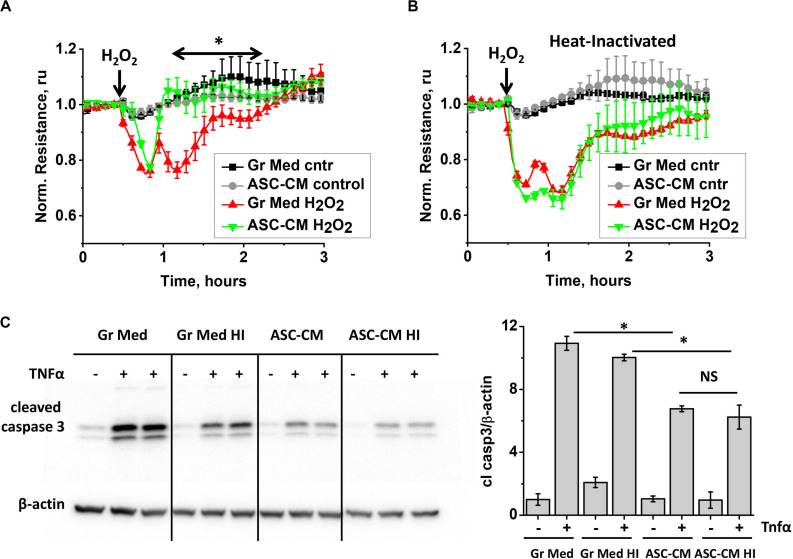
ASC-CM factors preserving transendothelial permeability are heat-sensitive, whereas factors preventing endothelial apoptosis are not. (A,B) HPAEC grown on gold electrodes of ECIS arrays were exposed to (A) the original growth media (black, red) or ASC-CM (gray, green) and (B) heat-inactivated growth media (black, red) or ASC-CM (gray, green). After 72 h of preconditioning, media were substituted with EBM-2, and HPAEC were challenged with 250 μM H2O2 (red, green) or vehicle (black, gray). Shown are the means ± SEM of three parallel recordings; the results were reproduced in at least three independent experiments. (C) HPAEC pretreated with the original or heat-inactivated (HI) growth media and ASC-CM were challenged with 2 ng/ml TNFα for 4 h. Cell lysates were analyzed with antibodies to cleaved caspase 3 and β-actin (loading control). Data from three independent experiments were pooled and presented as cleaved caspase 3/β-actin ratio mean ± SEM. One-way ANOVA with Tukey post hoc was used to detect whether differences between indicated columns are significant ∗(p < 0.05) or not significant (NS).